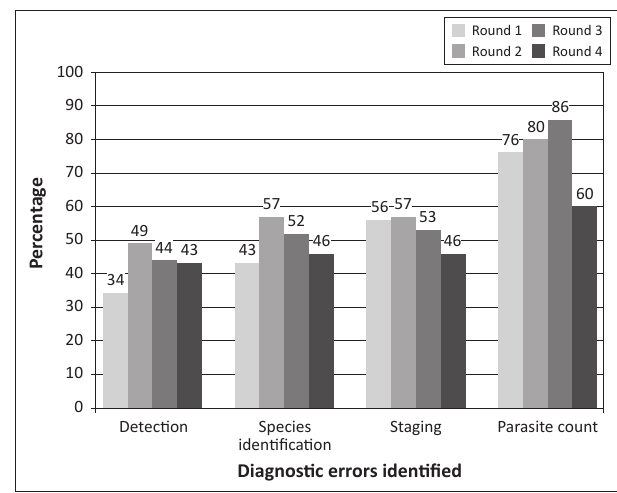
FIGURE 4: Frequency and types of errors identified in malaria diagnosis.